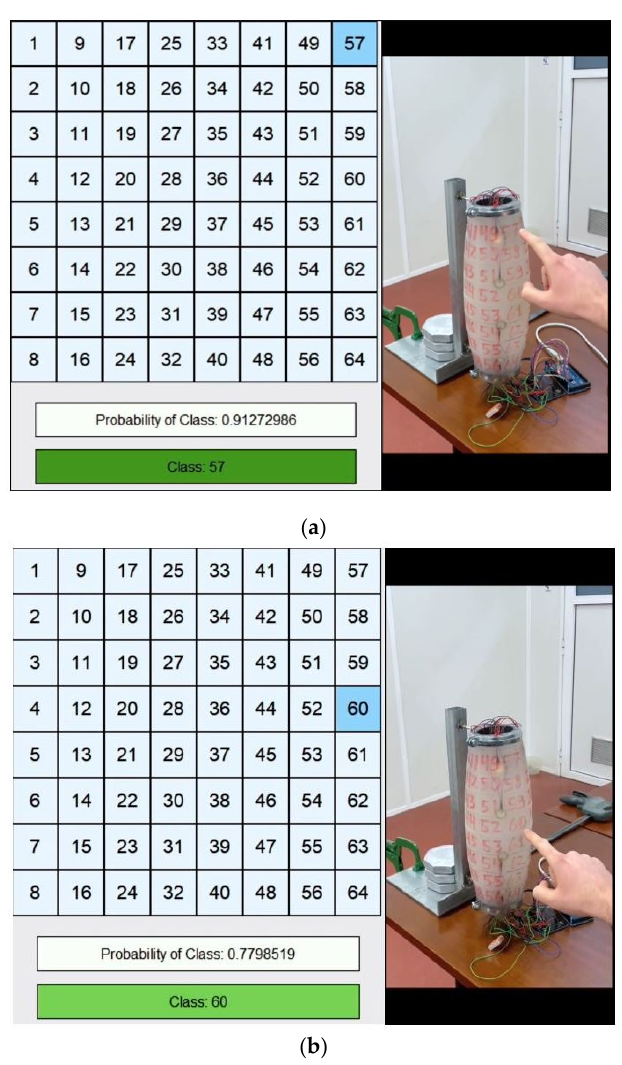
Figure 8. ( a ) Class 57 prediction; ( b ) Class 60 prediction.